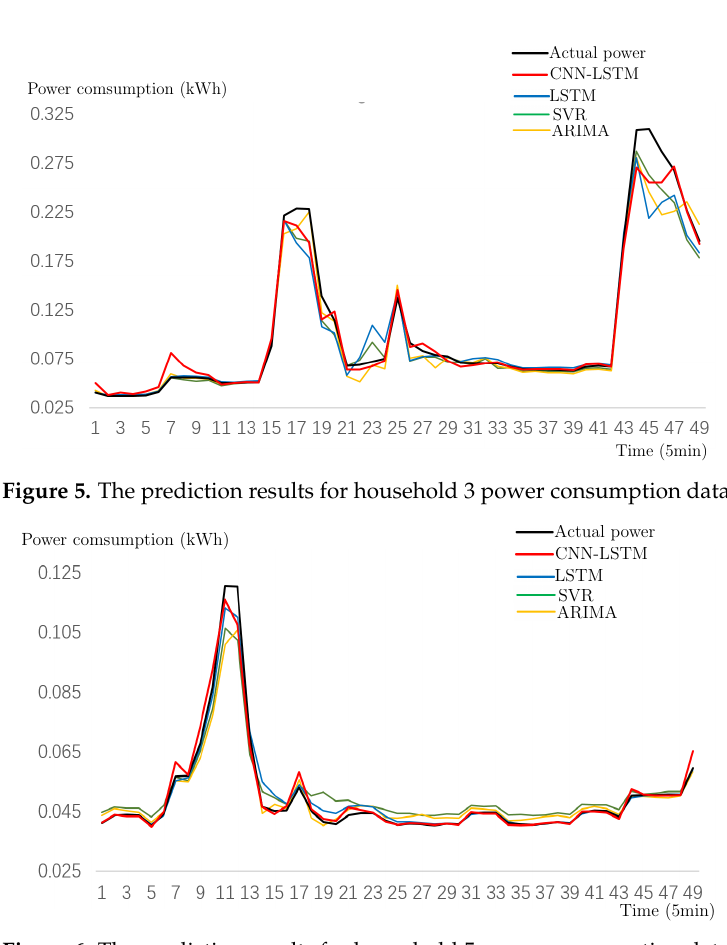
Figure 6. The prediction results for household 5 power consumption data. Table 3. Averaged RMSE and MAPE values for each household data. The value of k increases from 2 to 6. Metric RMSE MAPE